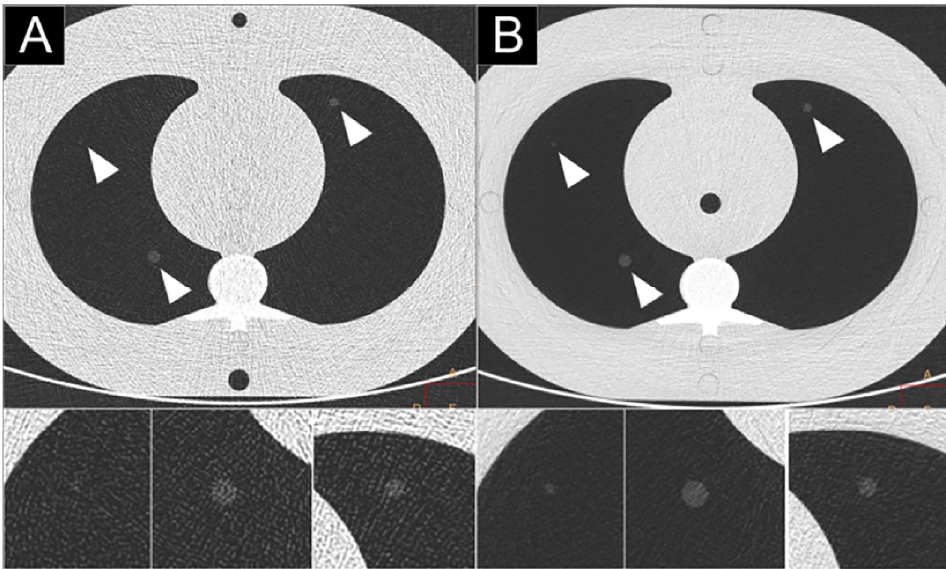
Figure 6. Comparison of high-resolution CT lung imaging of ground-glass nodules (2, 4, 6 mm) between a dual-layer EID-CT (iQon; Philips, Haifa, Israel) ( A ) and a clinical prototype PCD-CT (SPCCT; Philips) ( B ) in an anthropomorphic thorax phantom with an extension ring simulating an obese patient, using a standard dose protocol (120 kVp, 40 mAs).